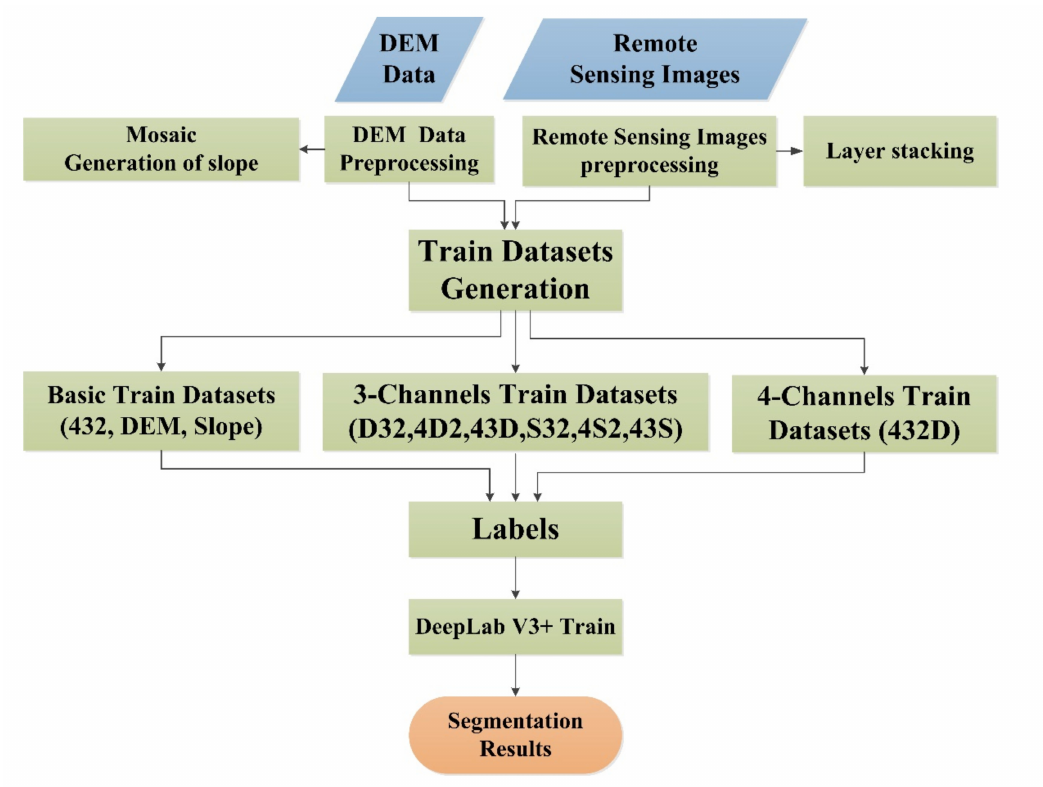
Figure 4. The processing flow of the proposed method to segment cone karst landscape based on the DeepLab V3+